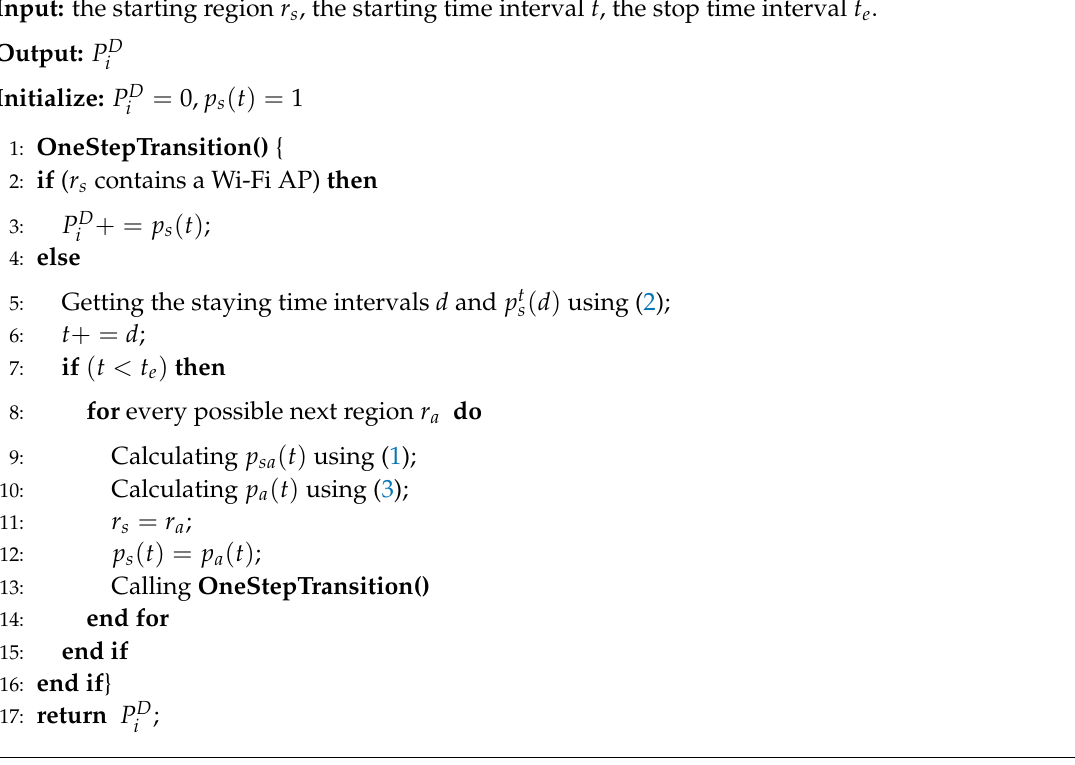
Algorithm 1 Predicting the probability of u i directly contacting a Wi-Fi Access Point (AP) within a time